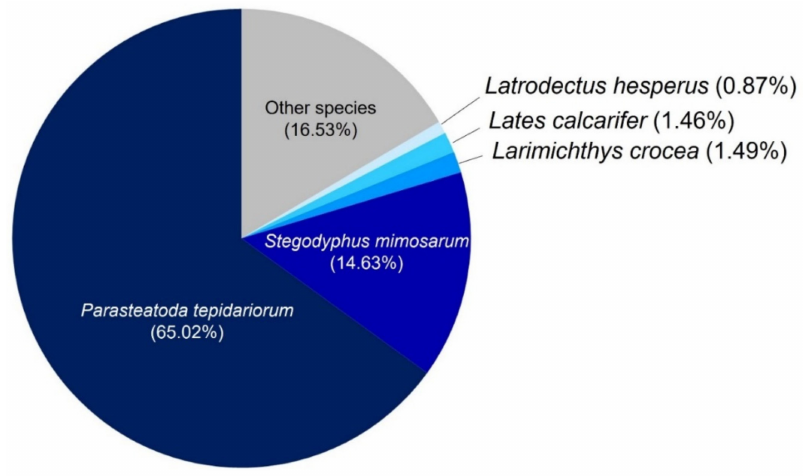
Figure 3. Species distribution showing the proportions of different species associated with the unigene annotations according to the results of the NR